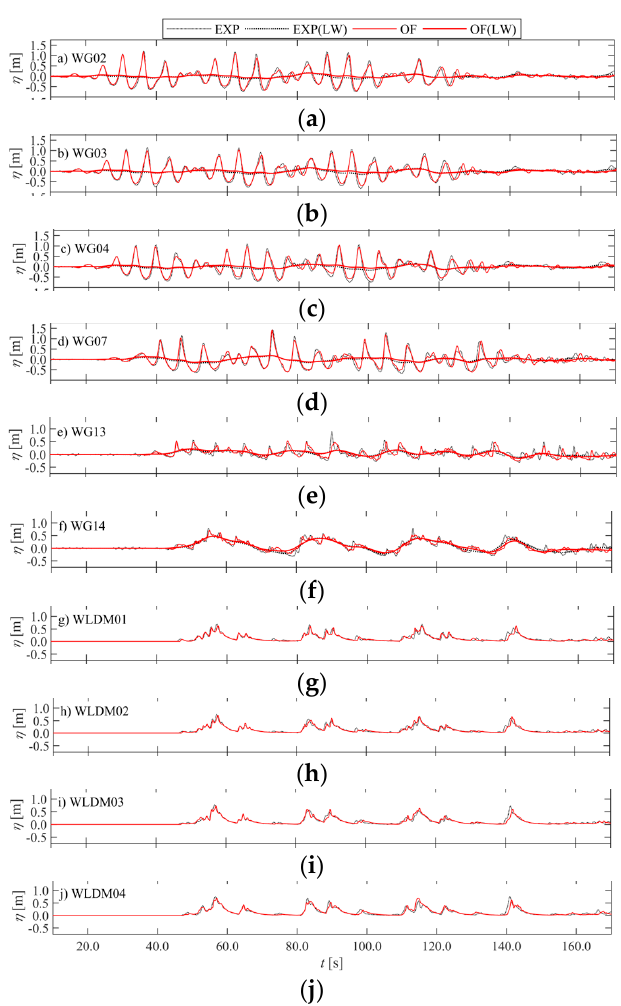
Figure 4. Comparison of the η time series at all sensor locations ( a – j ), including η LW in ( a – f ) (bold lines). The zero-reference is the SWL for ( a – f ) and the promenade bottom for ( g – j ).